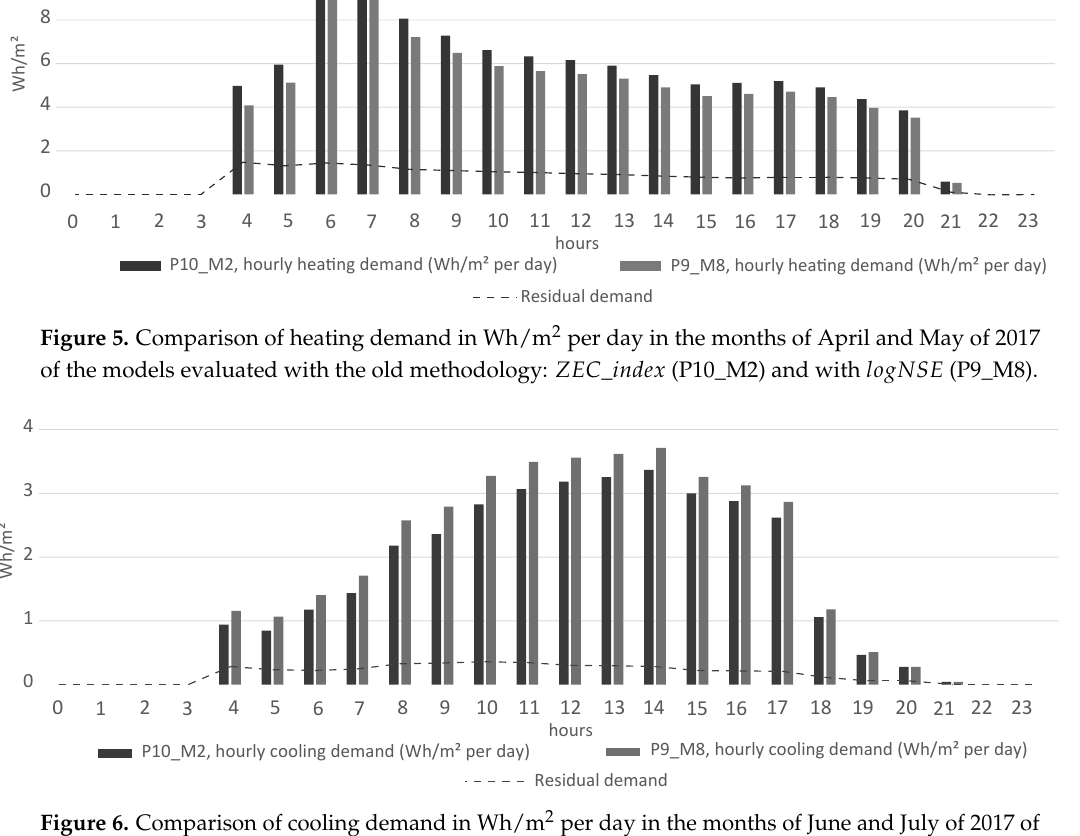
Figure 6. Comparison of cooling demand in Wh/m 2 per day in the months of June and July of 2017 of the models evaluated with the old methodology: ZEC _ index (P10_M2) and with logNSE